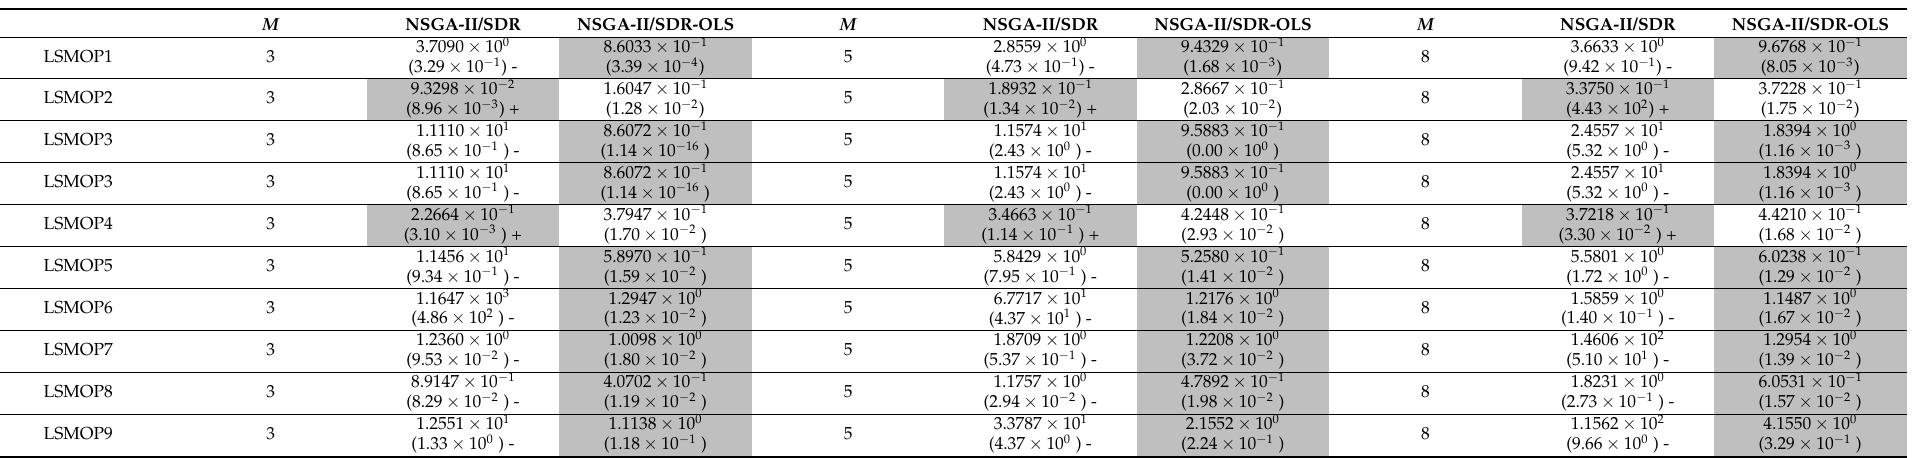
The gray background represents that this algorithm has the best performance on this problem. The number in the brackets represents the standard deviation of IGD values, and the number out of the brackets represents the mean of IGD values. “+/-/=” means that the relevant algorithm performs better than/worse than/as well as the NSGA-II/SDR-OLS algorithm in terms of IGD values. Table 3. IGD values compared with original NSGA-II/SDR with M = 10, 12, and 15.